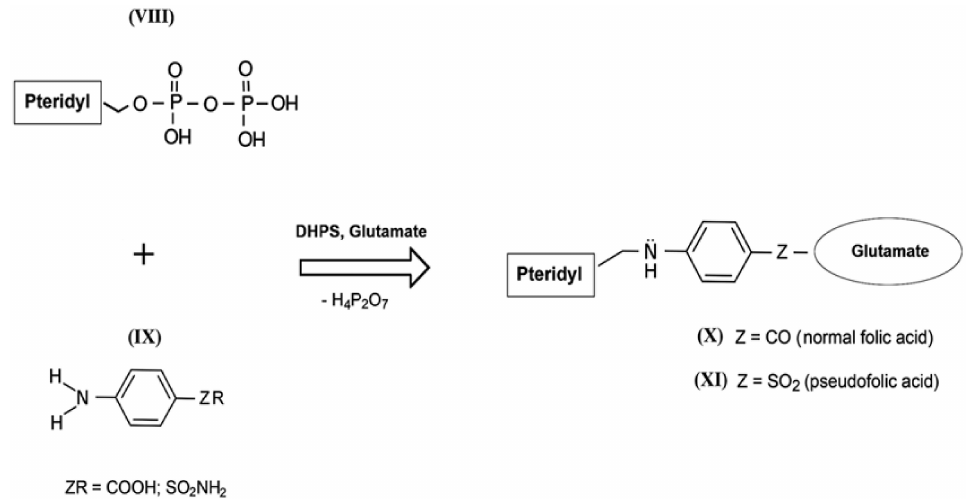
Figure 4. Simplified scheme of biosynthesis of normal folic acid (X) and pseudofolic acid (XI) (partly adapted from